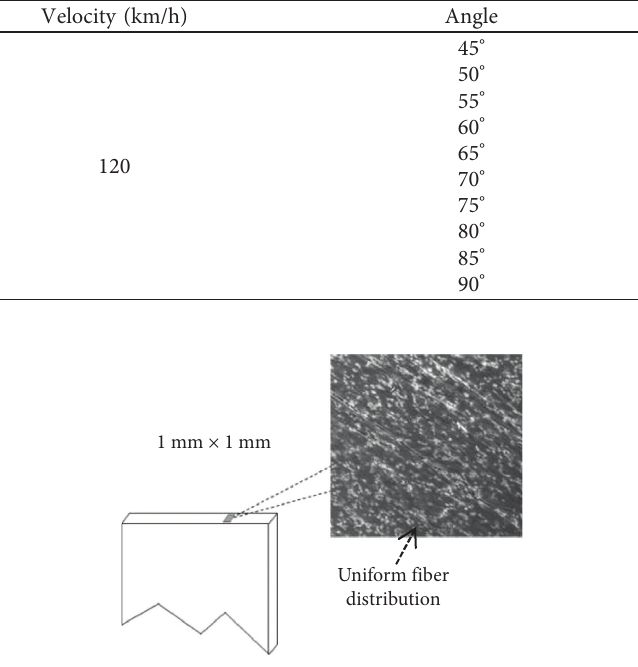
Figure 9: Scanning electron microscope image of oil sump material sampling (1mm × 1mm).